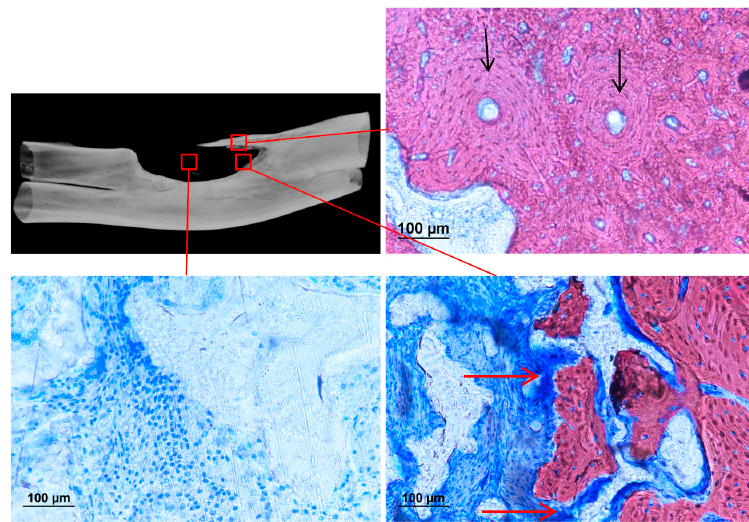
Figure 16. Histological staining of section in a different location inside the defect implanted with polyurethane composite filler (Alizarin red, counter-stained with Toluidine blue, 20×). Osteon can be found in the newly formed bones on the outgrowth (black arrow). Calcification can take place inside the porous system (red arrow).